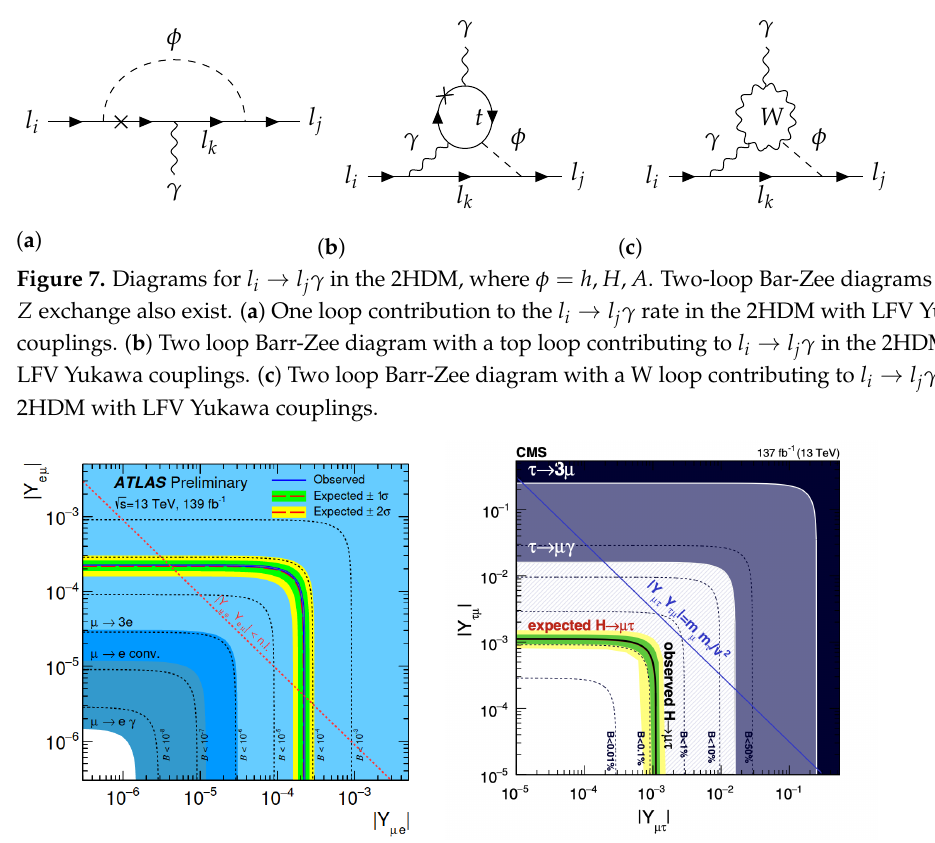
(cid:12) (cid:12) (cid:12) (cid:12) 2 < 2 m i m j / v (cid:12) Y ij Y ji (cid:12)